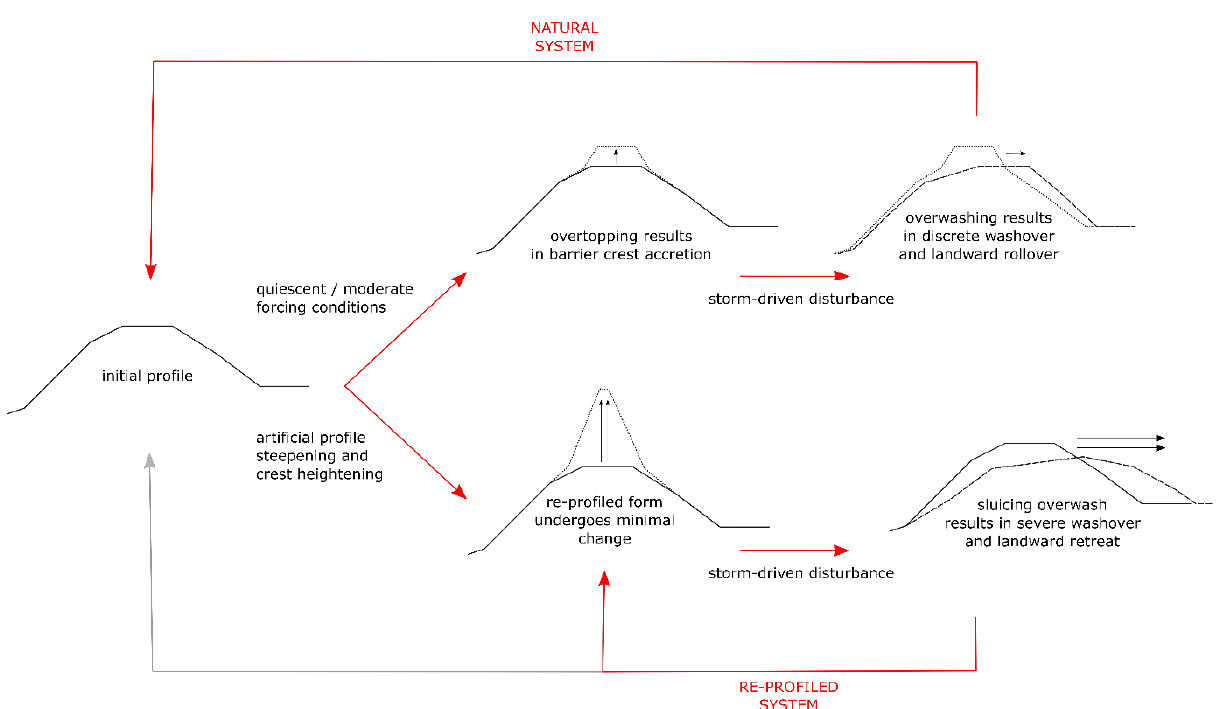
Figure 11. Management regime influence on barrier hydrodynamics and morphodynamics.